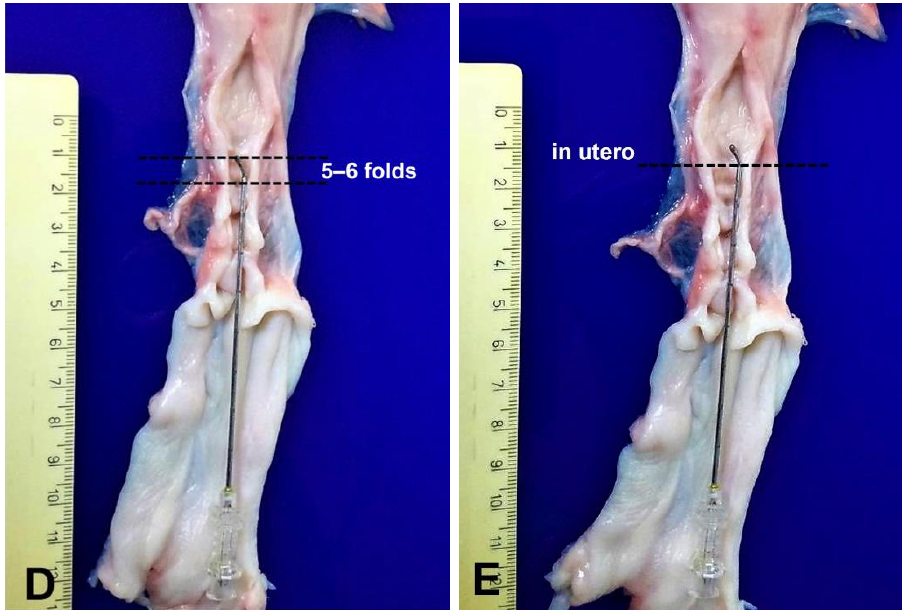
Figure 3. ( A ) Cervix of a pluriparous Sarda ewe characterized by 5 – 6 cervical folds that protrude into the cervical lumen; position of the 5 mm tip catheter when semen was deposited beyond ( B ) the first two folds; ( C ) the 3rd – 4th fold; ( D ) the 5th – 6th fold; ( E ) in utero.